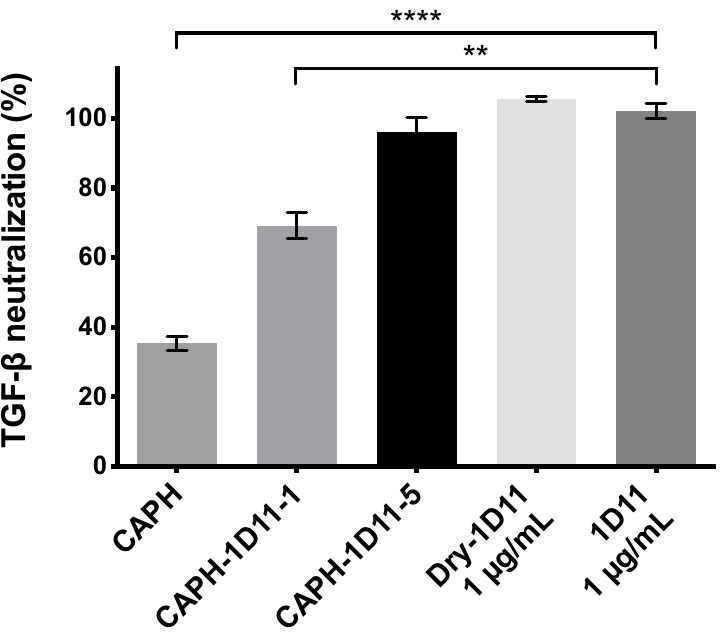
Figure 1. In vitro assessment of transforming growth factor-beta (TGF- β ) neutralization by pan- specific anti-TGF- β mouse monoclonal antibody 1D11.16.8 released from loaded Ca-alginate- poly(ethylene glycol) methyl ether methacrylate (PEGMA) hydrogels. HEK-Blue TGF- β cells were used to evaluate the capacity of Ca-alginate-PEGMA hydrogels (CAPH) loaded with 1 and 5 µ g 1D11.16.8 (CAPH-1D1-1 and CAPH-1D11-5, respectively) to release stable antibodies and neutralize 20 pM rhTGF- β 1. Dry-1D11 is a reconstituted antibody that was lyophilized and 1D11 is a soluble antibody without any drying. Each bar represents the mean ± SEM of 3 independent assays conducted in triplicate. Significance denoted by ** p < 0.01 and **** p < 0.0001.